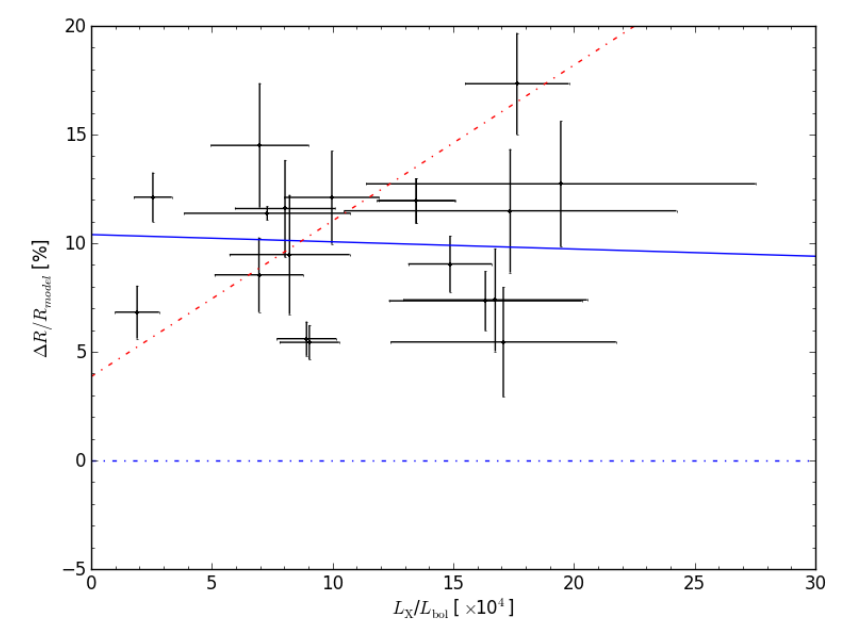
Figure 3. Relative radius difference with respect to the BHAC15 stellar models at 1Ga as a function of the X-ray to bolometric luminosity ratio. The solid-blue line depicts the best linear fit to the data, whose slope is not significantly different from zero. The red dot-dashed line illustrates the slope reported in López-Morales et al. [14] fitted to our data for comparison. The horizontal blue dot-dashed line is shown as a reference of agreement with the BHAC15 1Ga